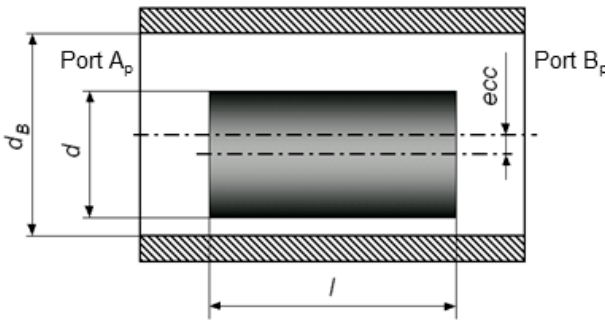
Figure 6. Ring gap for modeling the piston labyrinth seal.